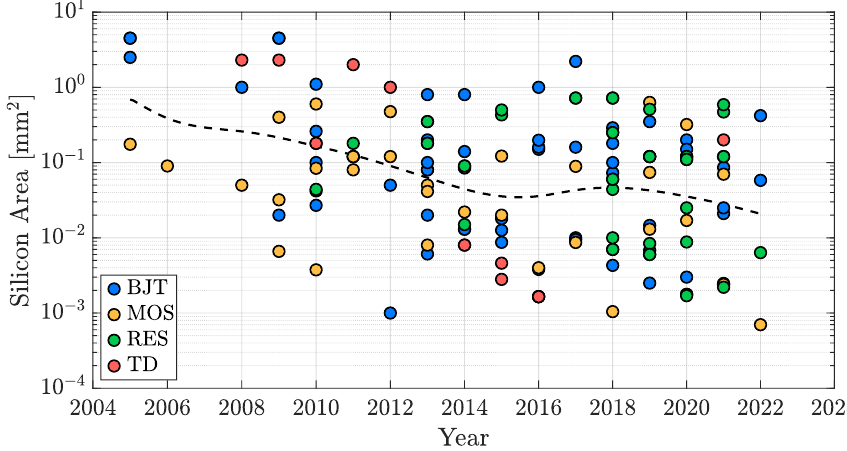
Figure 20. TDC silicon area time evolution in the last two decades.